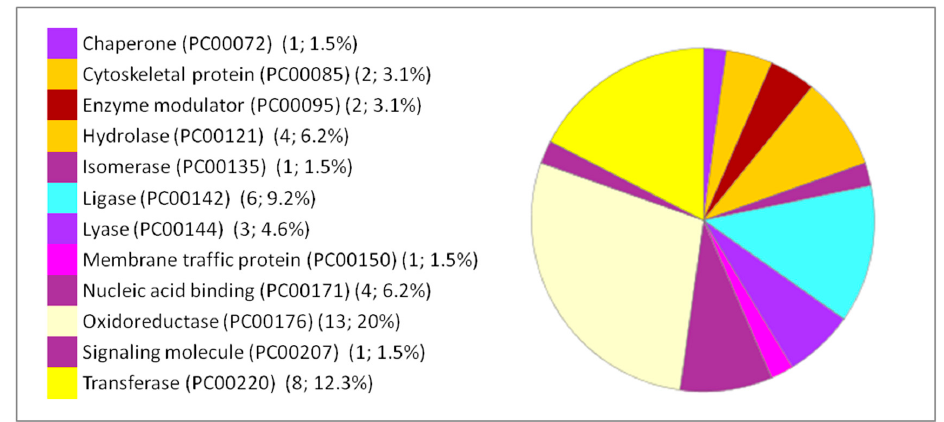
Figure 4. Functional classification of the 127 differentially expressed proteins in the brain following IONP exposure according to PANTHER protein class. The pie chart was generated from PANTHER Classification System. The number and percentage are given based on the 127 proteins. Protein name (Protein class PC) (Number of proteins; percentage from the 127 proteins).